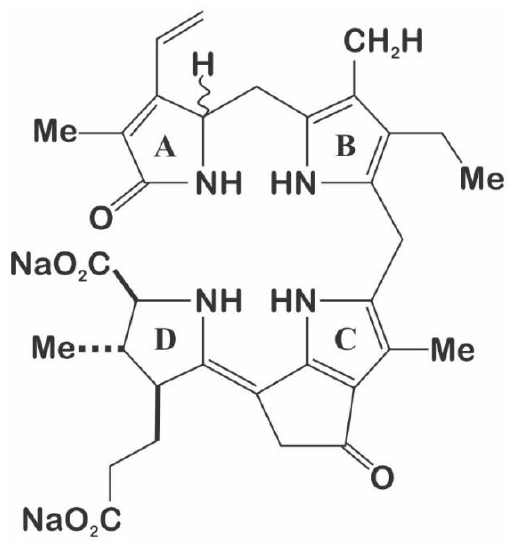
Figure 9. Structure of the dinoflagellate luciferin, according to Wang and Liu, (2017).